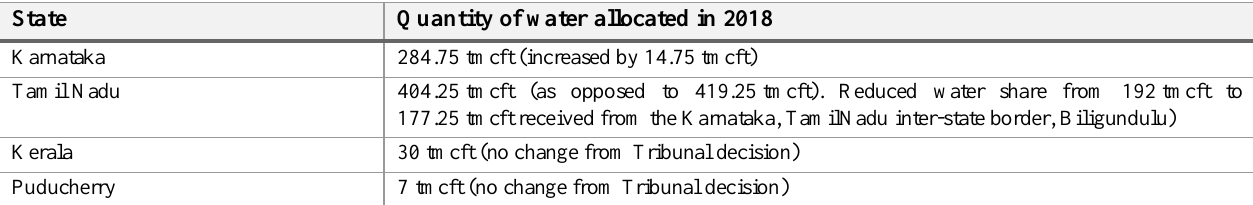
Table 1: Quantity of water allocated to Karnataka and other neighbouring states by the Supreme Court of India in 2018